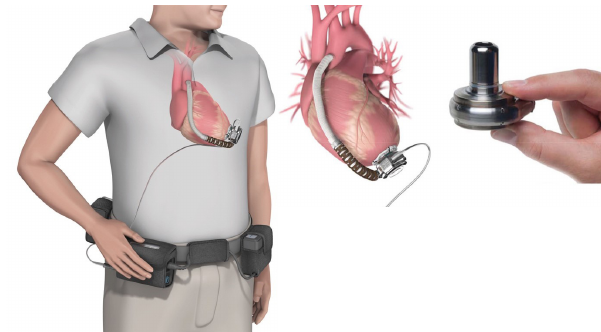
Fig. 4 - HeartWare® (HeartWare Inc, Framingham, Massachusetts, United States of America).